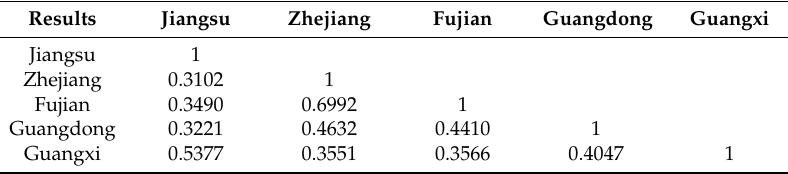
Table 5. Estimated DPGRA degree among China’s five main coastal